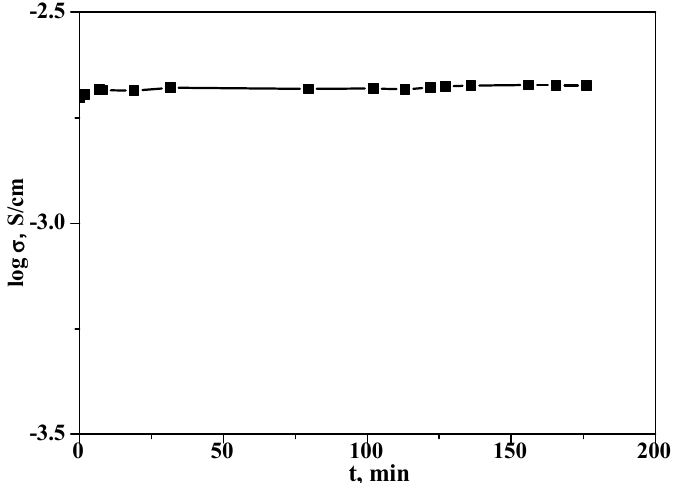
Figure 10. The time dependence of proton conductivity for (1 − x)CsH 2 PO 4 − xUiO-66 (x = 0.035) (isothermal holding: 240 °C, pH 2 O =0 .3 atm).